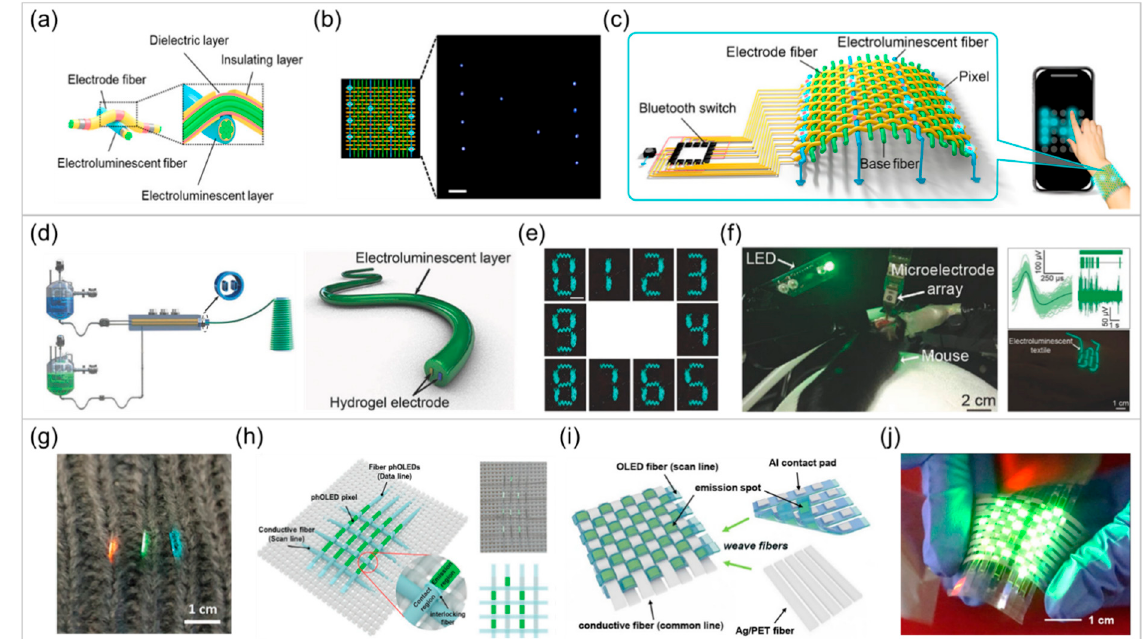
Figure 6. ( a ) Schematic illustration of a pixel structure in the electroluminescent fabric. ( b ) Schematic illustration and photograph of the electroluminescent fabric showing the pattern “N”. ( c ) Schematic illustration of the smart electroluminescent fabric being functionalized by connecting Bluetooth. ( a – c ) Reproduced with permission Ref. [65]. Copyright 2021, American Chemical Society. ( d ) Schematics of the simultaneous extrusion process and the light-emitting fiber ( e ) Photograph of an electroluminescent textile displaying numbers from 0 to 9. ( f ) Photograph of the real-time brain-interfaced camouflage of the fiber under green illumination. ( d – f ) Reproduced with permission Ref. [66]. Copyright 2018, Wiley-VCH. ( g ) Photograph of the RGB fiber PELDs, which are woven into clothes. ( h ) Left: schematic illustration of the textile display and a magnified schematic showing the contact region, the emission region, and the interlocking fiber. Right: photograph of the resulting textile display, which is integrated into the textile, visualizing the letter information “A”. ( g , h ) Reproduced with permission Ref. [15]. Copyright 2021, Wiley-VCH. ( i ) Schematic illustration of the woven OLED textile display consisting of orthogonally arranged arrays of interconnectable OLED fibers and conductive fibers. ( j ) Photograph of the working woven textile device comprising 10 × 10 fiber arrays by the passive matrix scheme. ( i , j ) Reproduced with permission Ref. [67]. Copyright 2021, American Chemical